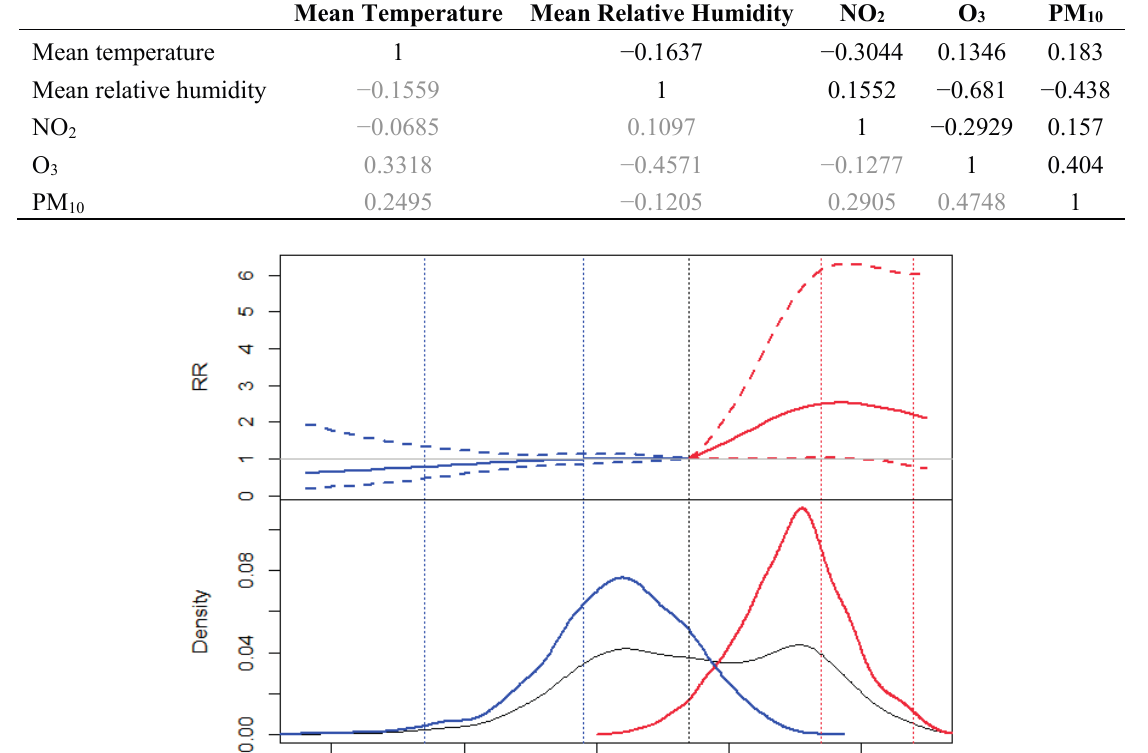
Table 3. Pearson correlation coefficients estimated between the corresponding daily environmental variables per season (grey shade for warm season; black for cold season).